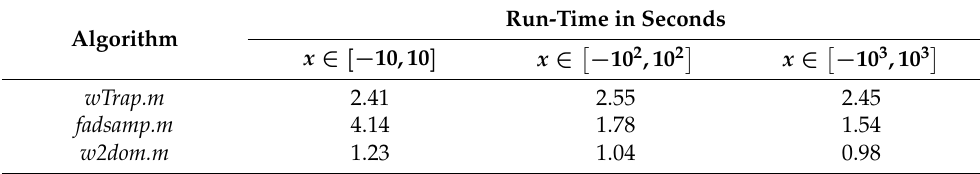
Table 1. Run-time of algorithms for 10 million points at three different ranges.